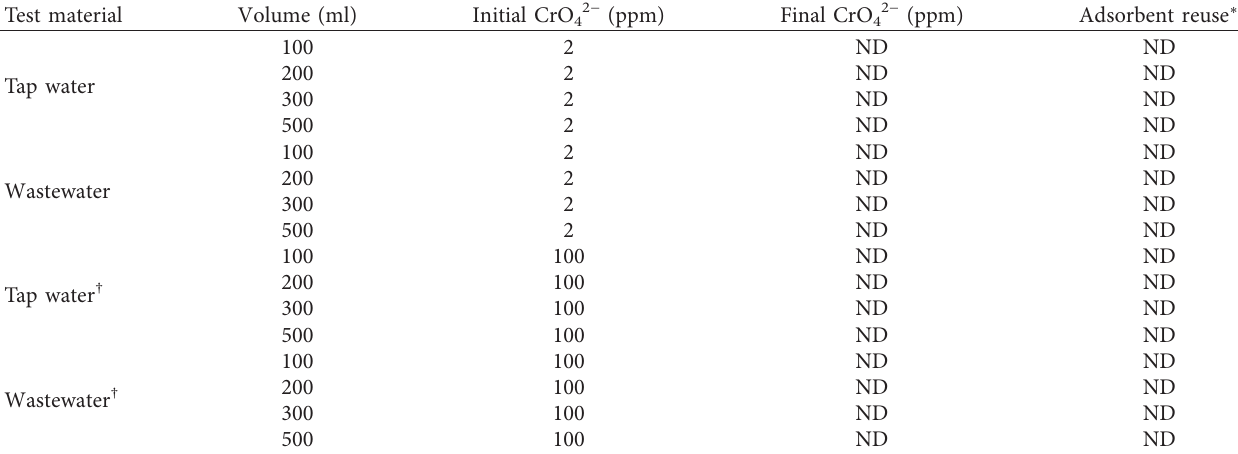
Figure 14: (a) Magnetic separation of a sample after reaction; (b) sample prepared for UV analysis using 1,5-diphenylcarbazide reagent. (c) A sample reduced from an initial concentration of 100ppm to 0ppm Cr(VI) with Fe 3 O 4 @SiO 2 @LEuH@PW 10 after 1 hour reaction time at 24 ° C and pH 6; ∗ dilution factor � 20. Table 1: Test results of 0.4g Fe 3 O 4 @SiO 2 @LEuH@PW 10 adsorbent with different chromate concentrations in both tap water and